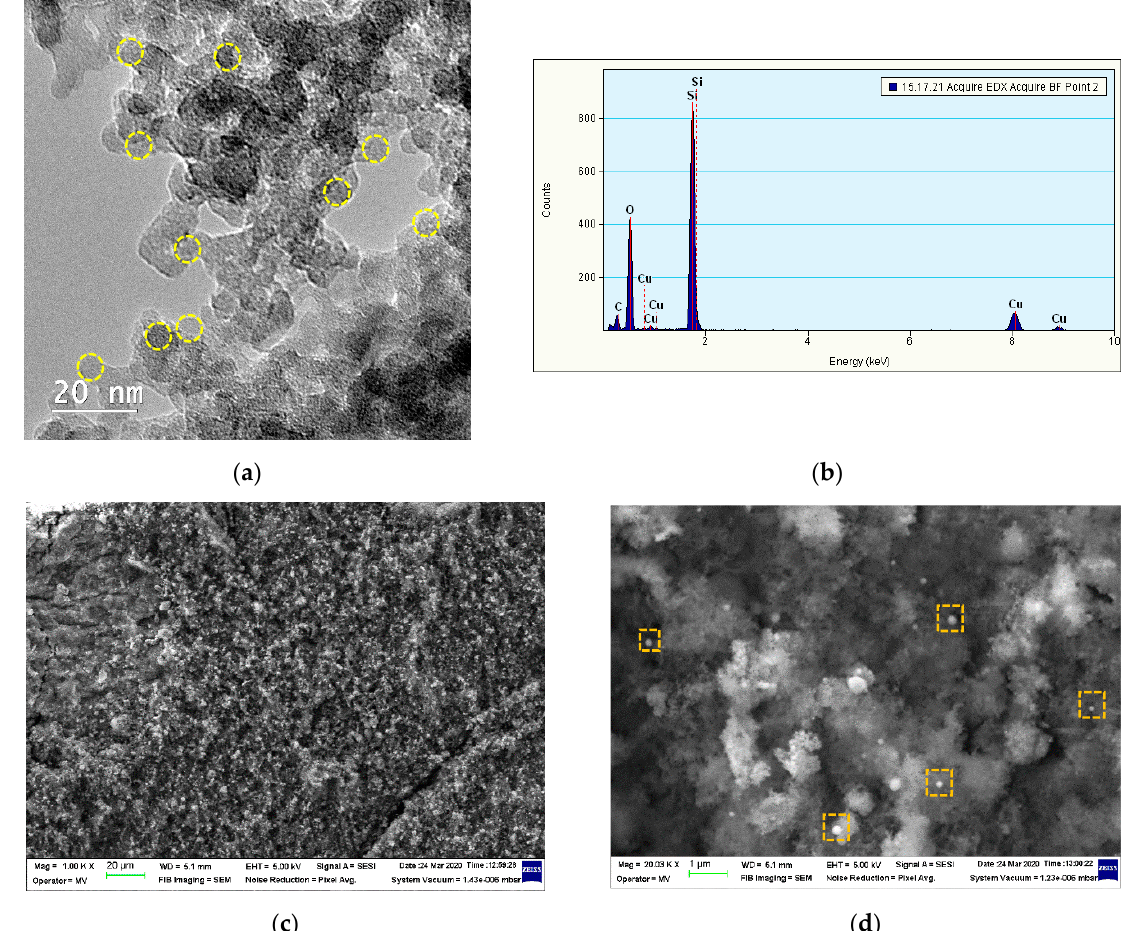
Figure 1. Characterization of Si/SiO 2 quantum dots (QDs) by TEM ( a ), EDXS ( b ) and SEM (scale bar of 20 µm ( c ) and scale bar of 1 µm ( d )) investigations. Note the spherical shape of QDs marked by yellow dot circles ( a ) and the presence of individualized spherical silicon mono-crystals of nanometer sizes marked by orange dot squares ( d ).